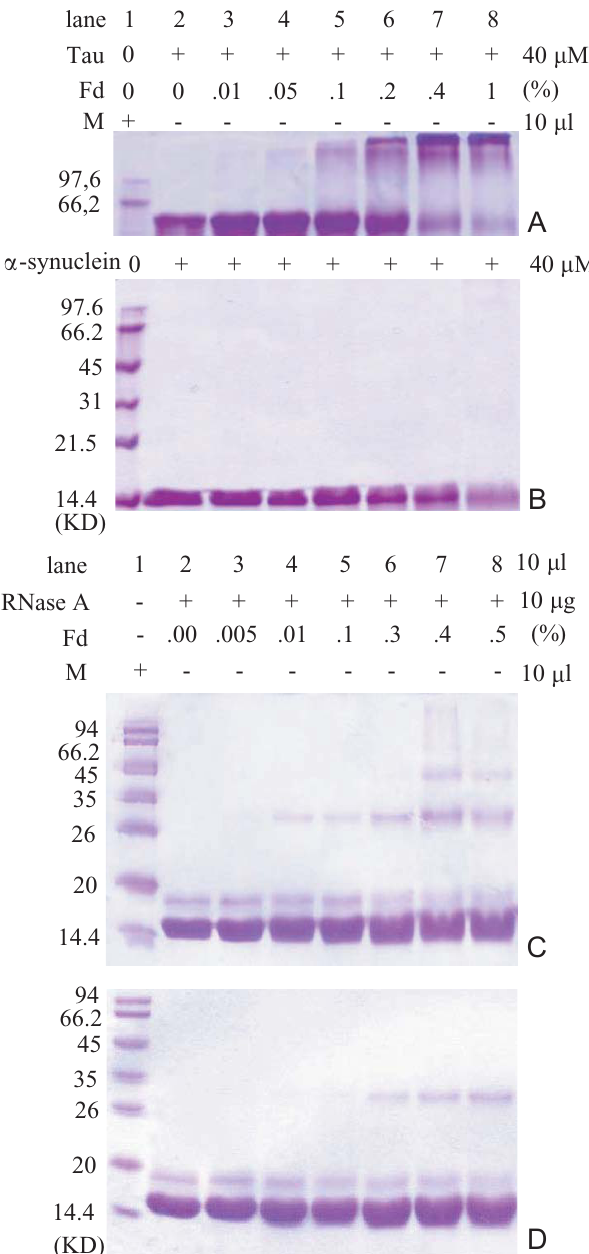
Figure 7. Formaldehyde-treated a -synuclein and RNase A on SDS- PAGE. Protein tau ( A ) or a -synuclein (amino acid sequence referred to NP_000336) ( B ) was incubated in 100 mM phosphate buffer (pH 7.2) containing formaldehyde at different concentrations as indicated at 37 u C over night, and then aliquots were taken for SDS-PAGE. RNase A (3 mg/ml) was pretreated with DTT (10 mM) in 100 mM phosphate buffer (pH 7.2) at 37 u C for 1 h and dialysed at 4 u C over night as described [31]. The dialysed RNase A (10 m g) was incubated with formaldehyde at different concentrations as indicated at 37 u C for 4 h ( C ). Aliquots were then taken for SDS-PAGE. RNase A incubated without DTT was used as control ( D ).